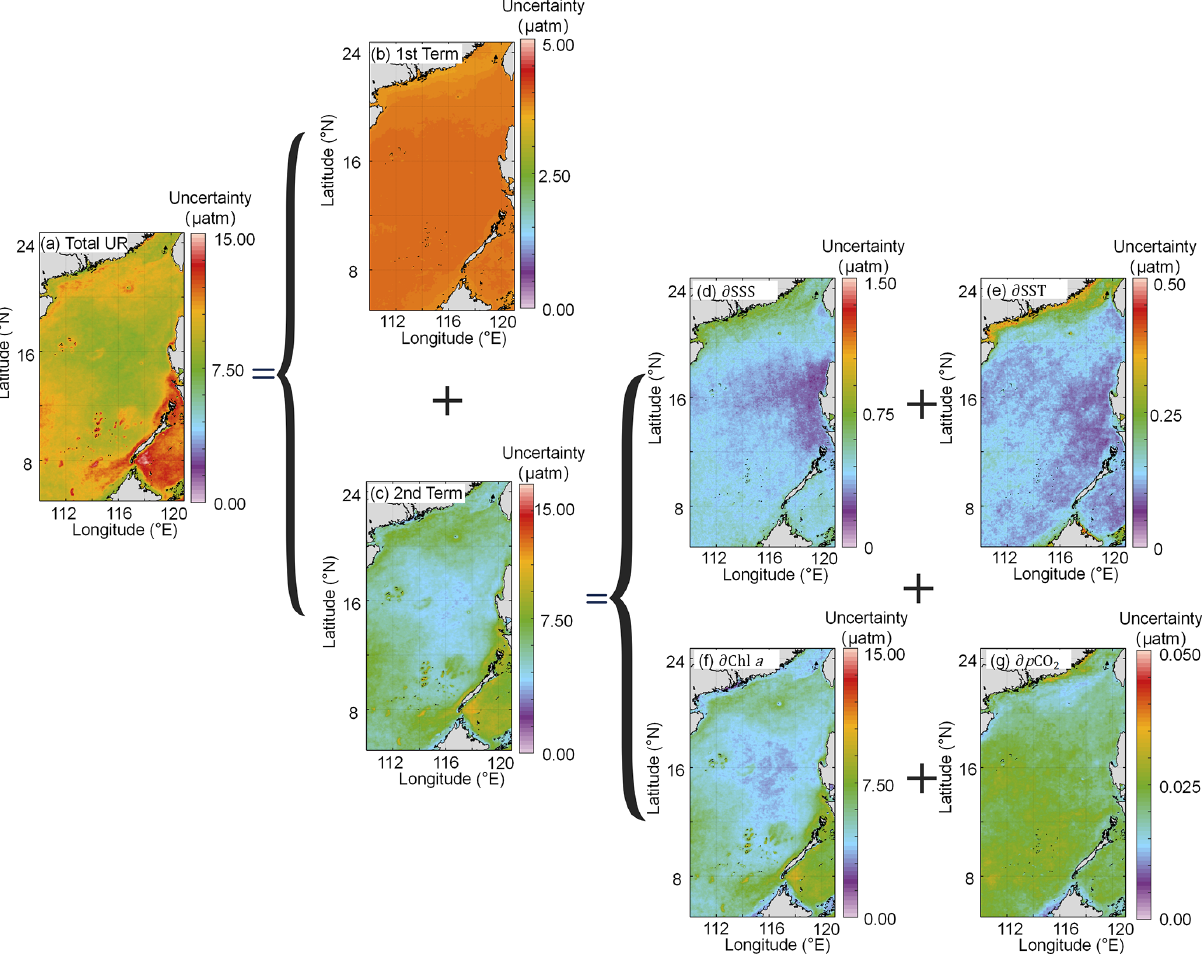
Figure 11. Uncertainties in the reconstructed p CO 2 fields. (a) Total uncertainty in Eq. (6). (b) The first term of Eq. (6). (c) The second term )dSSS in the second term of Eq. (6). (e) ( ∂p CO 2 )dSST in the second term of Eq. (6). (f) ( ∂p CO 2 of Eq. (6). (d) ( ∂p CO 2 ∂ SSS ∂ SST term of Eq. (6). (g) ( ∂p CO 2 )dRS_derived_ p CO 2 in the second term of Eq. ∂ RS_derived_ p CO 2